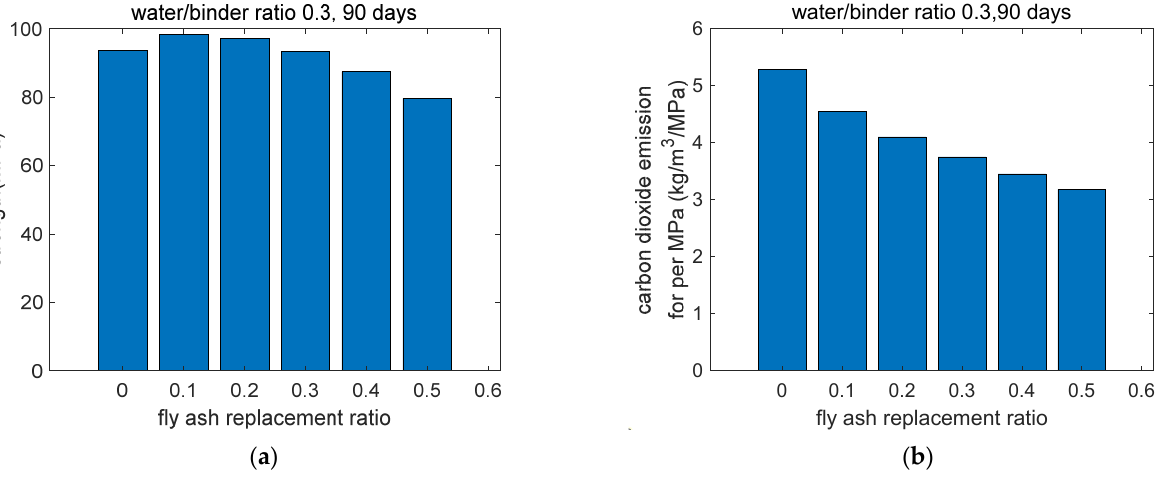
Figure 8. CO 2 emissions for concrete at 90 days and W/B ratio = 0.3.( a ) Strength at 90 days. ( b ) CO 2 emissions for 1 MPa strength.